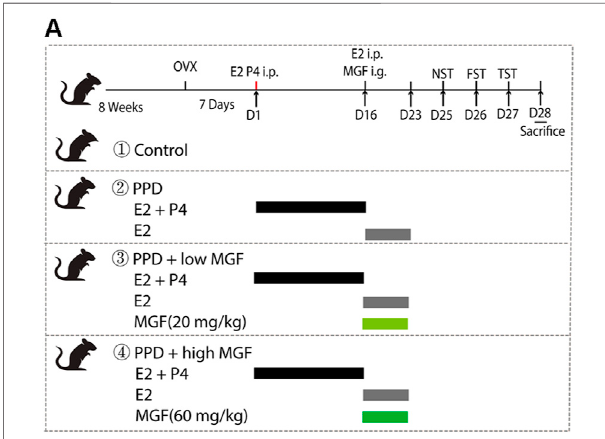
FIGURE 1 | Timeline of experimental design, including the schedule of the hormone-stimulated pregnancy (HSP)-induced postpartum depression (PPD)micemodelanddrugadministrationandbehaviortests.FemaleBALA/c mice were ovariectomized bilaterally for 7 days. The ovariectomized mice were injected intraperitoneally with β -estradiol (E2, 0.5 μ g/day) and progesterone (P4, 0.8 mg/day) for 16 consecutive days. Progesterone was then withdrawn, and a high dose of β -estradiol (10 μ g/day) was administrated alone. At the same time, two-dose concentrations of mangiferin (MGF) were administrated to the treatment group